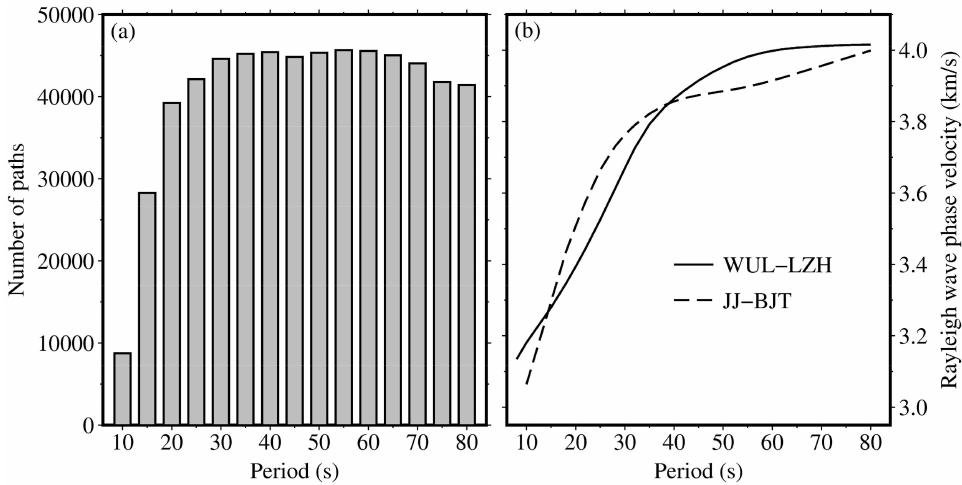
Figure 3. ( a ) Number of paths at each period; ( b ) Rayleigh wave phase velocity dispersion curves of the station pairs WUL–LZH and JJ–BJT. The paths of station pair WUL–LZH and JJ–BJT are shown in Figure